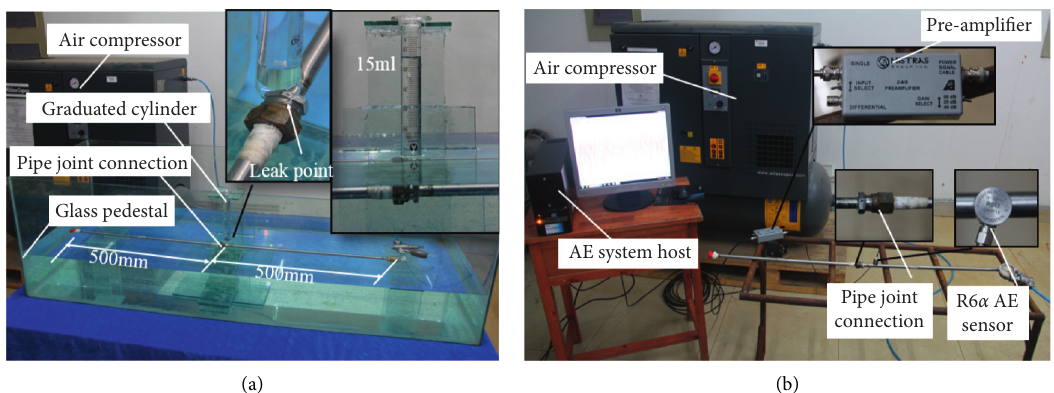
Figure 1: Experimental setup: (a) calibrating leak rate; (b) recording leak AE